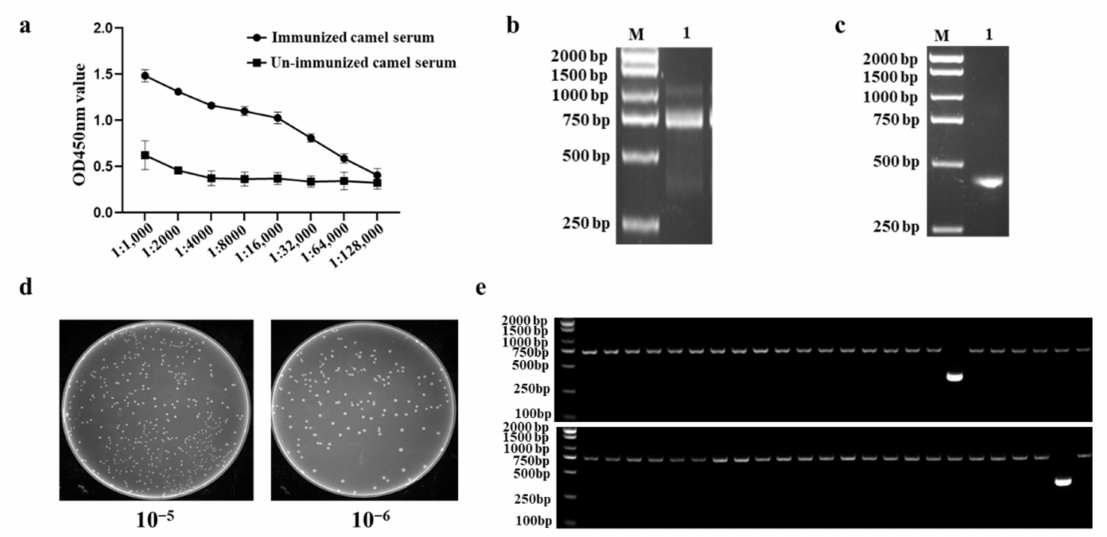
Figure 2. Construction of the VHH library against IBV-N protein. ( a ) Detection the antibody titer of serum samples from the immunized with IBV-N protein. ( b ) The first PCR fragment had a target band of about 700 bp; M: Marker DL2000, Lane 1: the first PCR products (~700 bp). ( c ) The VHH genes were re-amplified by second PCR, around 400 bp; M: Marker DL2000, Lane 1: the second PCR products (~400 bp). ( d ) The capacity of the VHH library was calculated by the plate count method, and it reached 8.0 × 10 9 cfu/mL. ( e ) The correct insertion rate detected by PCR of 48 individual clones was nearly 96% (46/48).